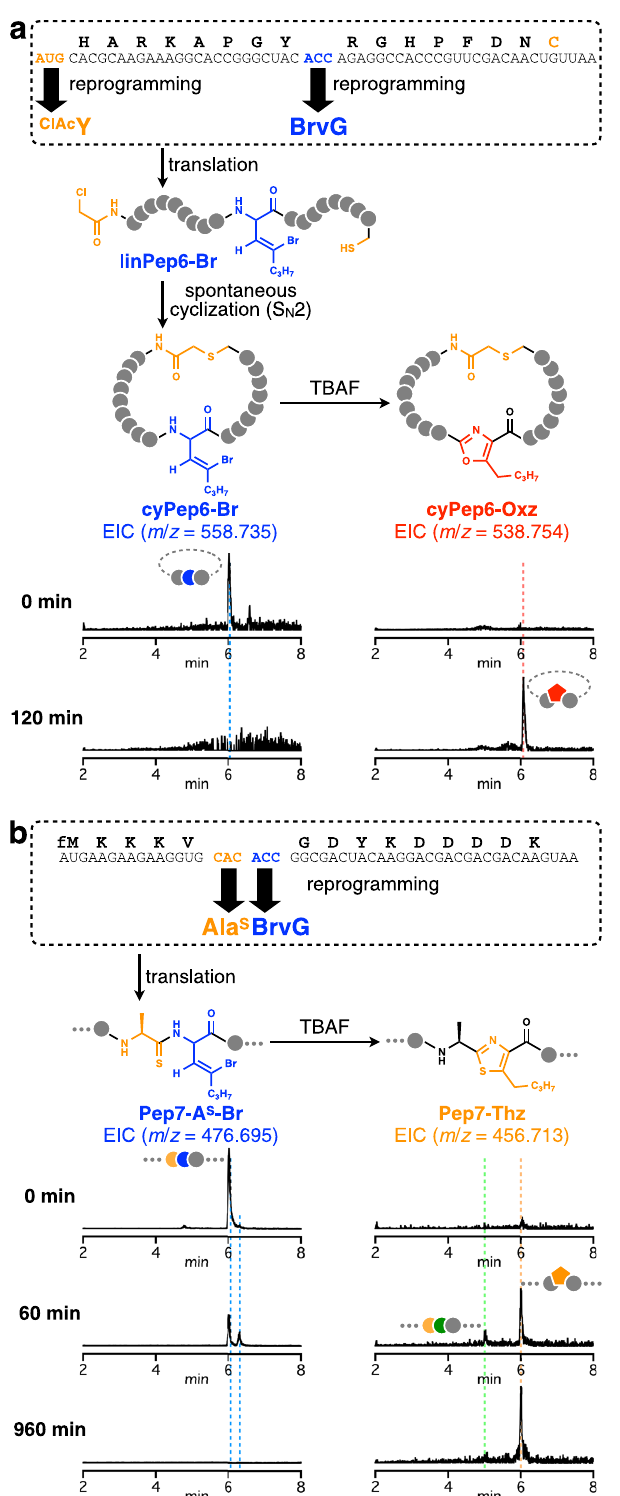
Fig. 5 Application of the chemical posttranslational modi fi cation of BrvG for the synthesis of various peptides bearing azole moieties. a Ribosomal synthesis of a thioether-closed macrocyclic peptide bearing a backbone oxazole. b Ribosomal synthesis of a peptide bearing a thiazole moiety. The peaks corresponding to translated precursors, intermediates bearing AkyG, the cyclic peptide with an oxazole, and the thiazole-containing peptide are labeled with blue, green, red, and orange dotted lines, respectively. Additional EICs of more time points monitored during the synthesis of Pep7-Thz are shown in Supplementary Fig.